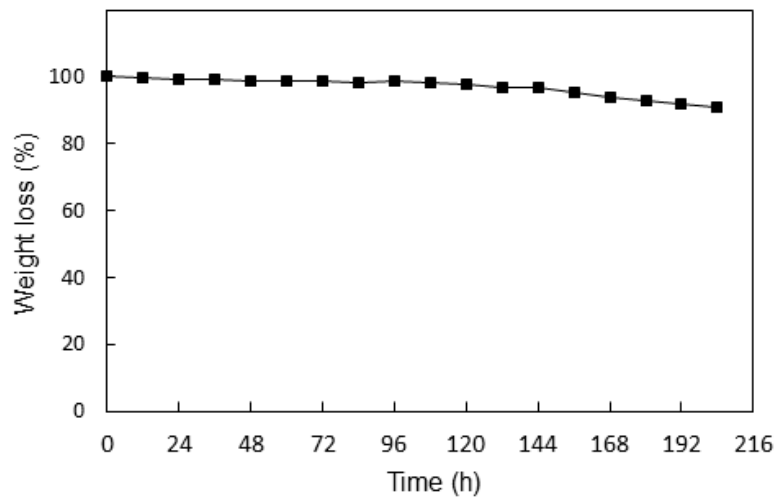
Figure 14. Variation of weight loss (%) with time during treatment of ETFE-g-P(4-VP/1-VIm)/PA membrane in Fenton reagent.